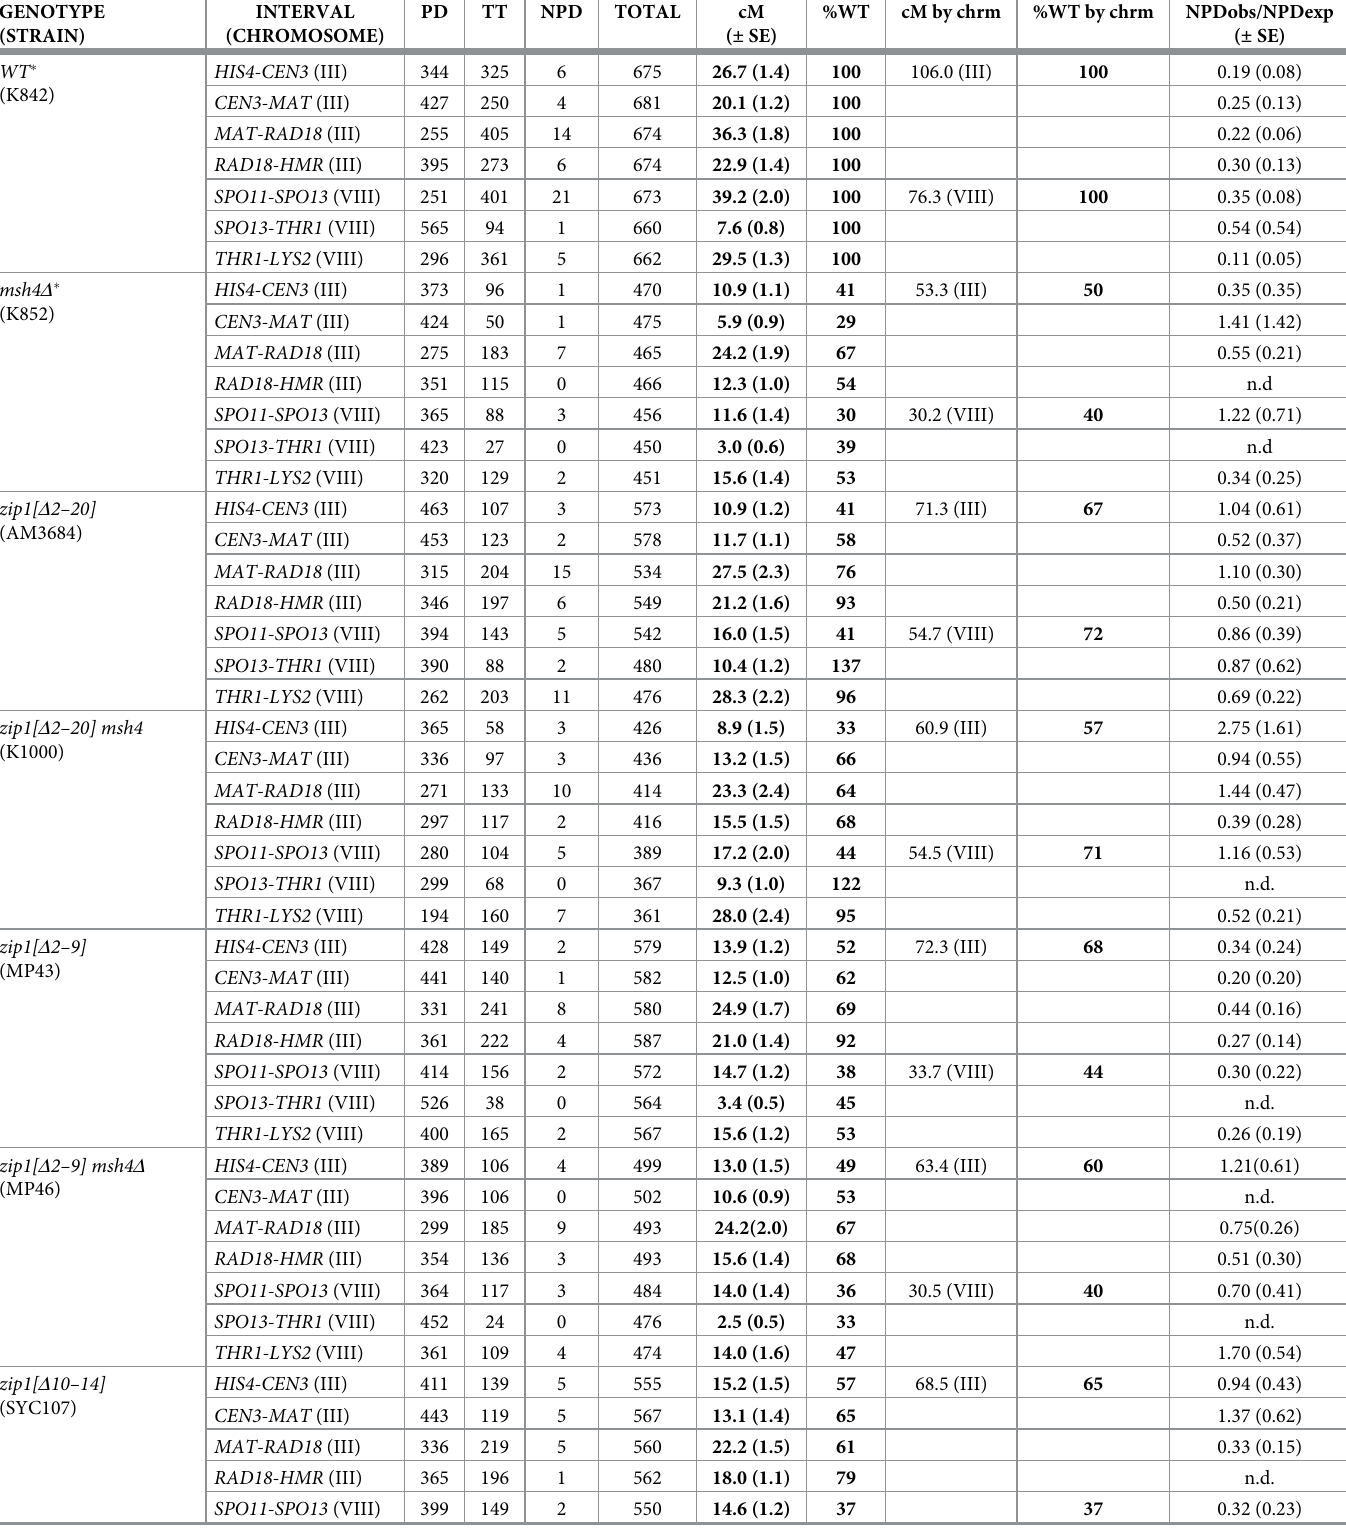
Table 2. Genetic map distances in mutant strains; PCH2 background. GENOTYPE